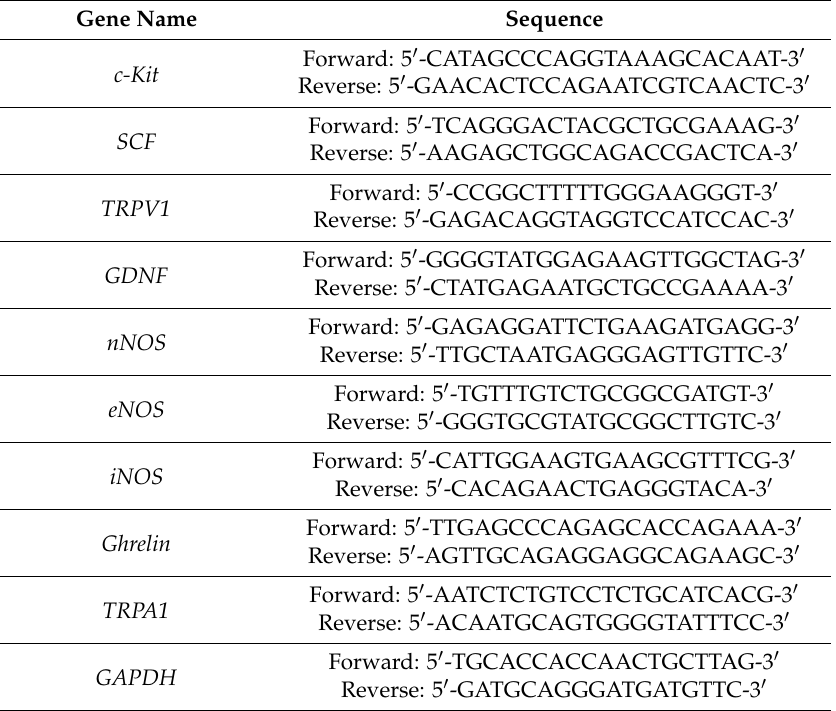
Table 1. Sequences of primers used in this